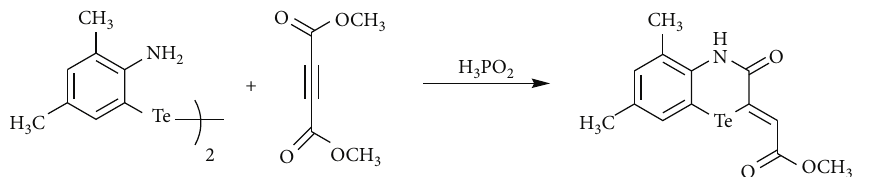
Figure 3: Previously reported preparation of methyl (Z)-2-(5,7-dimethyl-3-oxo-3,4-dihydro-2(H)-benzo[b] [1, 4]tellurazin-2-ylidene)